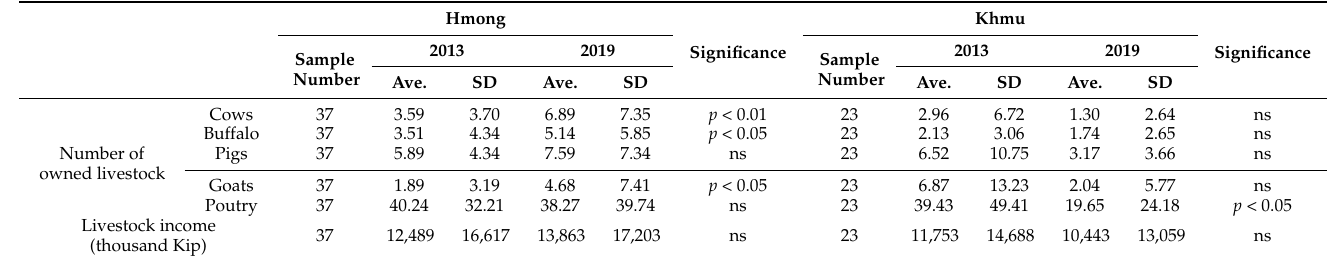
Table 2. Comparisons of average livestock ownership and income generation with standard deviation (SD) for Hmong and Khmu ethnicities for 2013 and 2019.